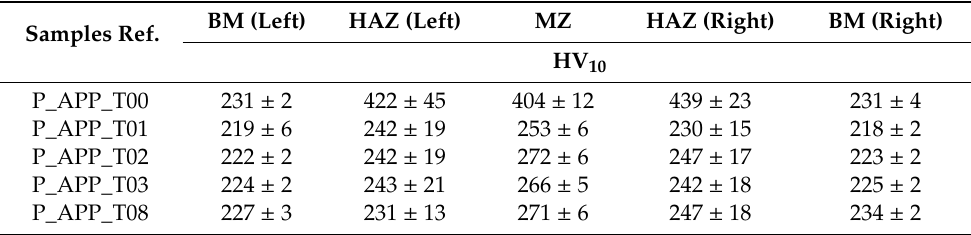
Table 7. Cross-section microhardness of the different samples (HV 1 ).